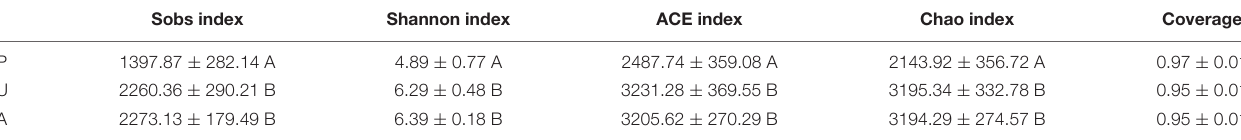
TABLE 1 | α -Diversity for bacterial communities in sediment samples with standard